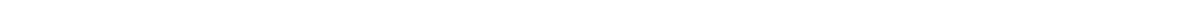
Fig. 4 Stem cells trigger target cell invasion via paracrine activation of mTORC1. a Immunostaining of indicated tissues from Matrigel- or ESC-injected mice for the detection of mouse cyclophilin A and phosphorylated S6. Nuclei were counterstained with DAPI. The dotted line in the ʽ T (edge) ’ panel delineates the border between adjacent and teratoma (T) tissue. Scale bar , 20 μ m. b Quanti fi cation of cyclophilin A+ cells with induced S6 phosphorylation in the adjacent tissue of ESC-injected mice ( n ≥ 7; mean ± s.d.). Data are based on immunostainings as presented in a . #, non-detectable. c Immunostaining of adjacent tissue from ESC-injected mice for the detection of phosphorylated S6 and MMP14. Nuclei were counterstained with DAPI. Pictures show double- positive ( open arrowheads ) and double-negative ( fi lled arrowhead ) murine cells. Scale bar , 10 μ m. d Immunoblot for the detection of mTOR target proteins in IMR-90 cells co-cultured with AFSCs for 2 h. Data were densitometrically evaluated (OD). e Immunoblot for the detection of mTOR target proteins in IMR-90 cells treated with AFSC-conditioned medium for 1 h. Data were densitometrically evaluated (OD). The asterisk next to the CAD S1859 panel indicates a non-speci fi c band. f Transwell invasion assay of IMR-90 fi broblasts treated with Rapamycin and co-cultured with stem cells ( n ≥ 4; mean ± s.d.). The ef fi ciency of Rapamycin treatment under the chosen assay conditions was evaluated via immunoblotting of phosphorylated S6. g The experiment in f was performed for all ESC and iPSC lines described in Fig. 1a. Results are presented in groups summarising the data for all ESC and iPSC lines including data in f ( n = 12, ESC TOTAL ; n = 38, iPSC TOTAL ; mean ± s.d.). h Transwell invasion assay of Rapamycin-treated cardiac fi broblasts upon stem cell co-culture and immunoblot of phosphorylated S6, as performed for IMR-90 in f ( n ≥ 3; mean ± s.d.). * P < 0.05; ** P < 0.01; *** P <